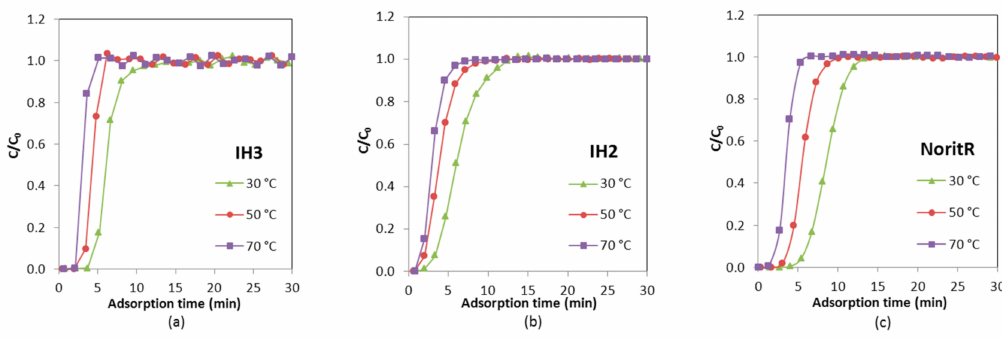
Figure 7. Breakthrough curves of CO 2 at different temperatures (30, 50 and 70 ◦ C) for samples: ( a ) IH3; ( b ) IH2; and ( c ) Norit